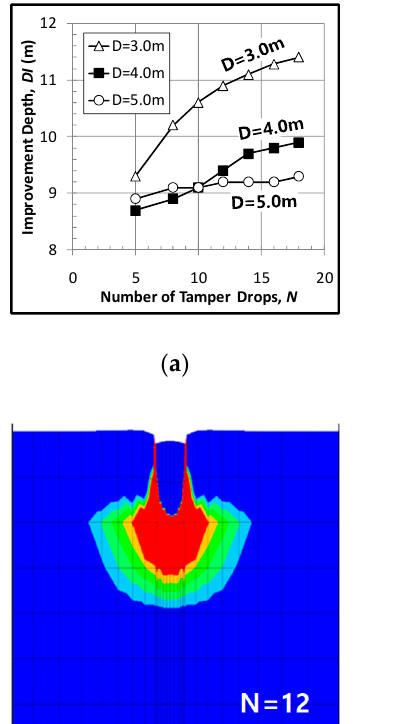
Figure 10. Horizontal and vertical displacement due to compaction (D = 4 m, W = 20 tons, N = 12, H = 15 m): ( a ) ground settlement distribution; ( b ) horizontal displacement contour; ( c ) vertical displacement contour.